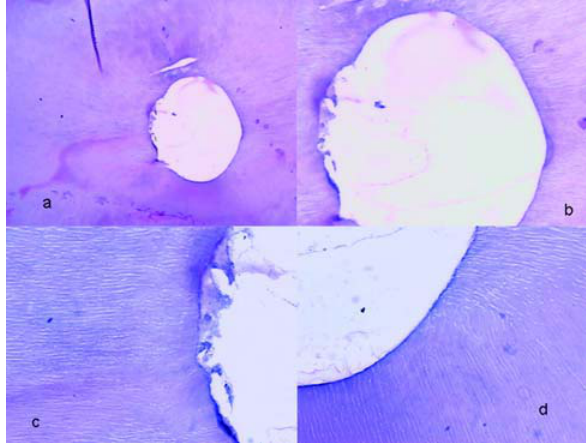
FIGURE 3- Group III- F3 instrument associated with 2.5% sodium hypochlorite irrigation (HE, a-40x; b-100x; c and d-